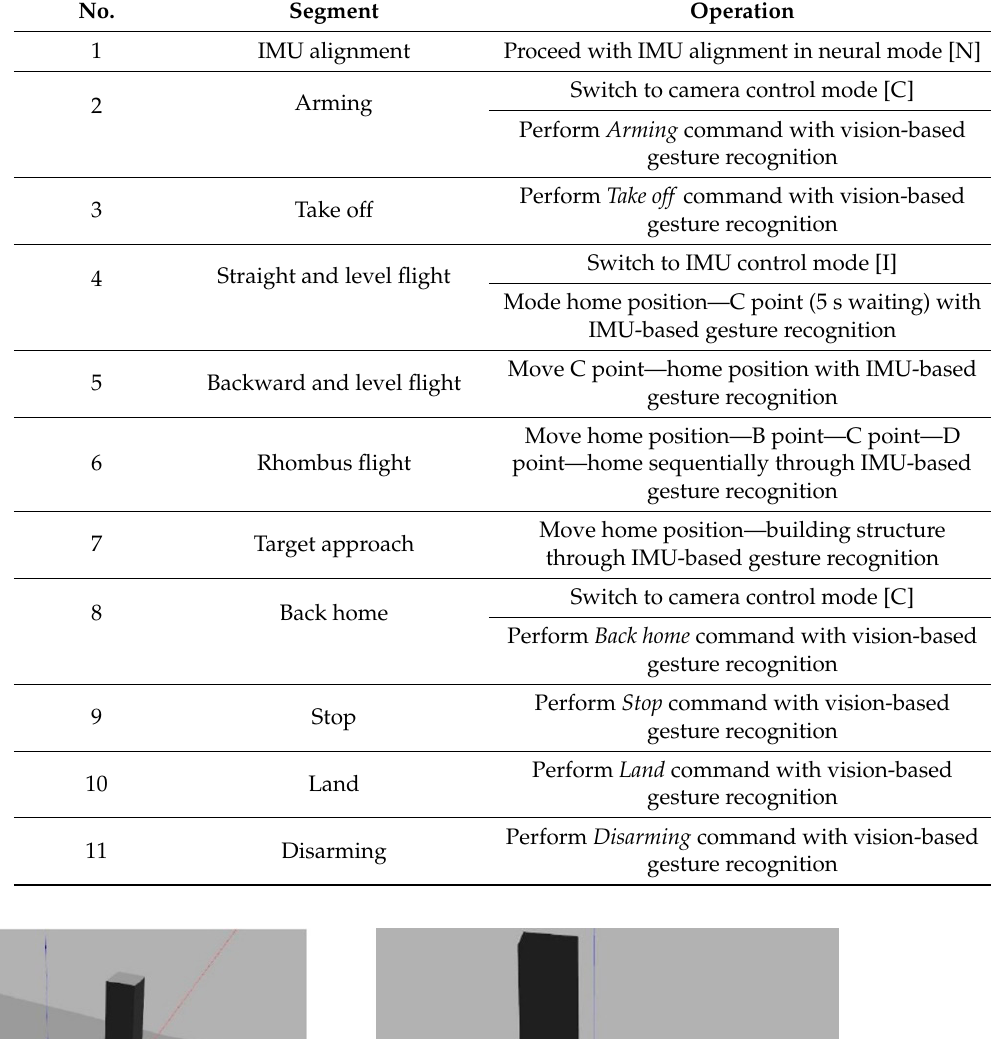
Table 3. Test scenario procedure.